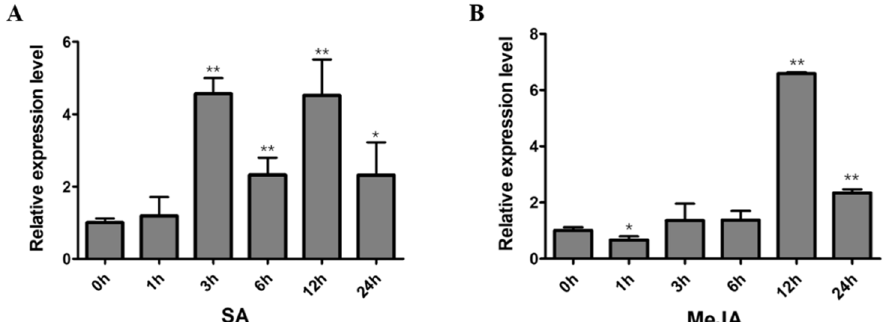
Figure 6. Expression of GmNAC12 under SA and MeJA hormone treatments. ( A , B ) Expression of GmNAC12 in roots under SA (2 mM) and MeJA (100 µM) treatments determined by qRT-PCR ( n = 3). The data represent the means ± SEs. * p < 0.05 (Student’s t -test). ** p < 0.01 (Student’s t -test).